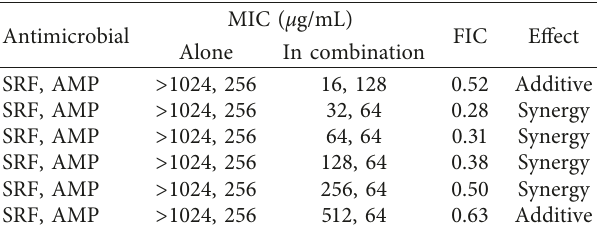
Table 3: MIC of SRF and AMP used alone and in combination against P. aeruginosa ATCC